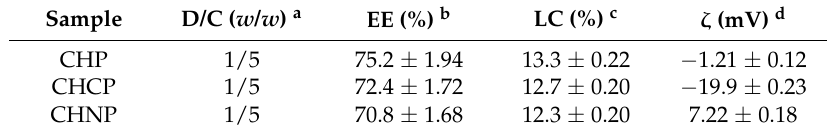
Table 1. Characteristics of mitoxantrone-loaded pullulan NPs with different surface charge.